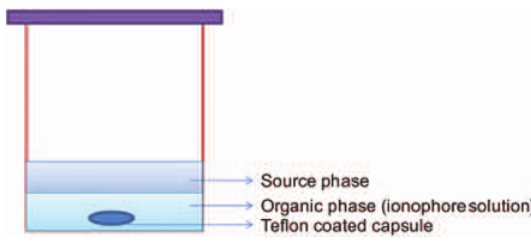
Figure 1 Apparatus set-up for extraction. Figure 2 Apparatus for bulk liquid membrane